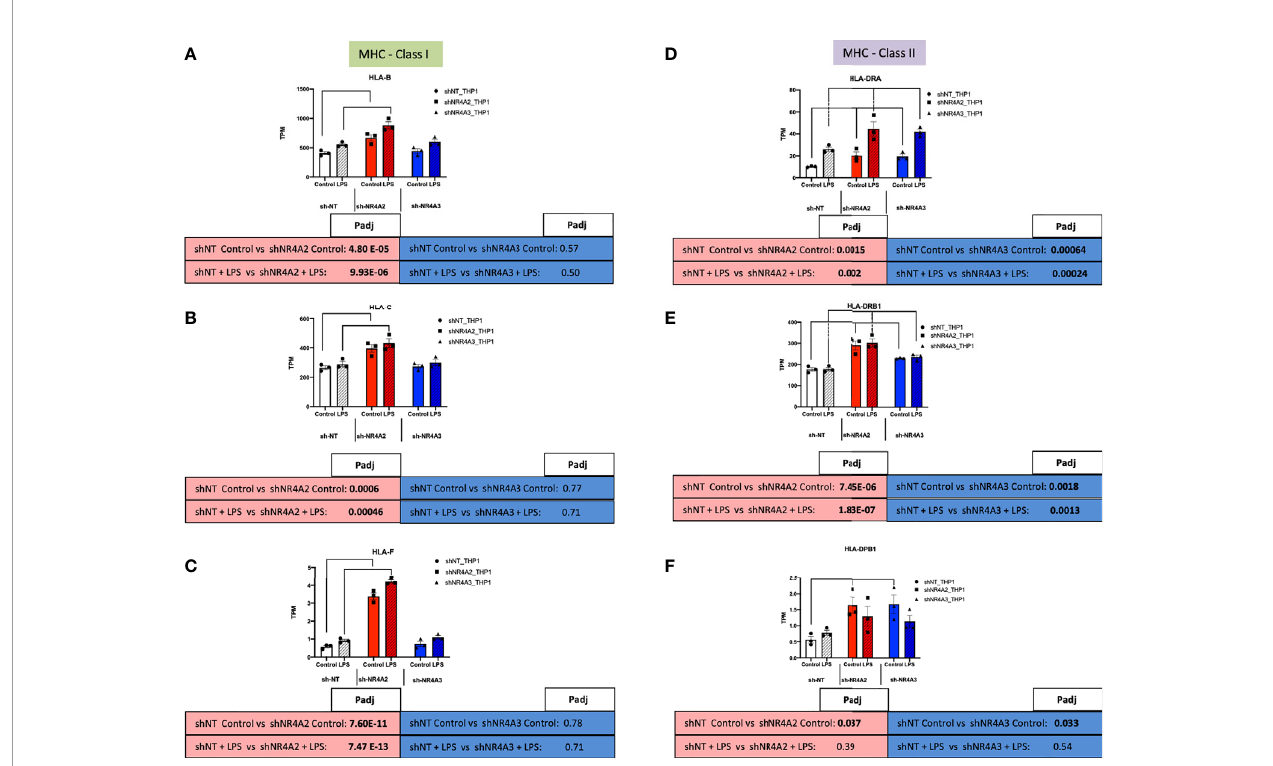
FIGURE 10 | Knockdown of NR4A2 alters MHC Class1 gene expression. RAW TPM values (mean +/- SEM) extracted from RNA-seq for genes associated with MHC-Class I (green rectangles) and MHC-Class II (purple rectangles). Data shown for HLA-B (A) HLA-C (B) HLA-F (C) HLA-DRA (D) HLA-DRB1 (E) and HLA-DPB1 (F) in shNT-THP1 cells, shNR4A2-THP1 cells and shNR4A3-THP1 cells in the control (unstimulated state) and following LPS treatment (2.5 m g/ml for 2hrs). N=3 independent experiments. Adjusted p-values (Padj) for speci fi c comparisons are contained in the tables below the TPM data. Statistically signi fi cant Padj are denoted in bold font. Comparisons between shNR4A2 cells and control are denoted in the red boxes, comparisons between the shNR4A3 cells and control are denoted in the blue boxes. Statistically signi fi cant comparisons are further signposted using bars on the TPM